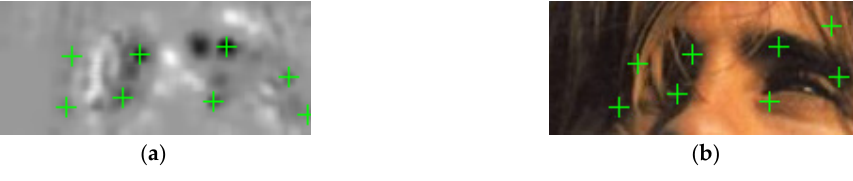
Figure 15. Failure cases of eye center localization. ( a ) Symmetry transform image and selected eye candidates; and ( b ) selected eye candidates (on the input image).